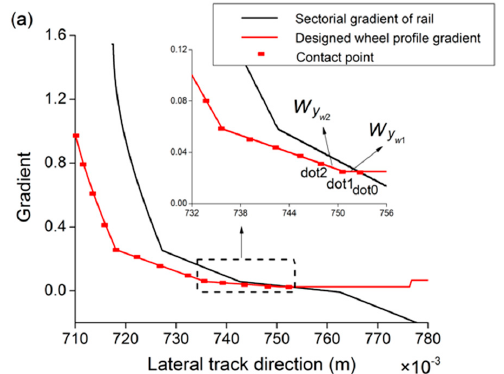
Figure 5. Reverse design of wheel profiles.